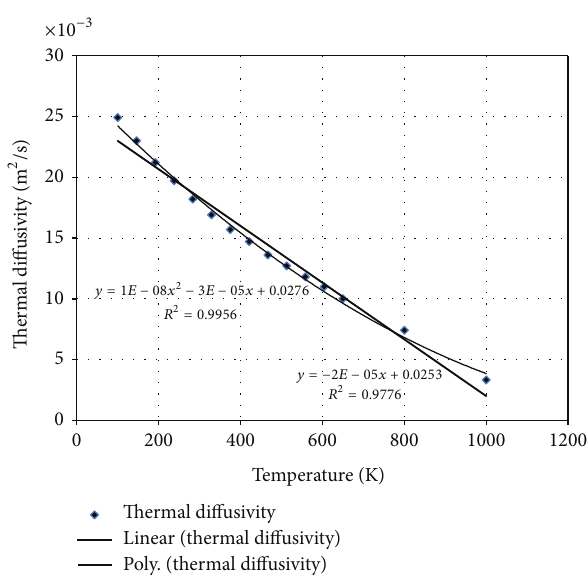
Figure 2: Thermal diffusivity of mild